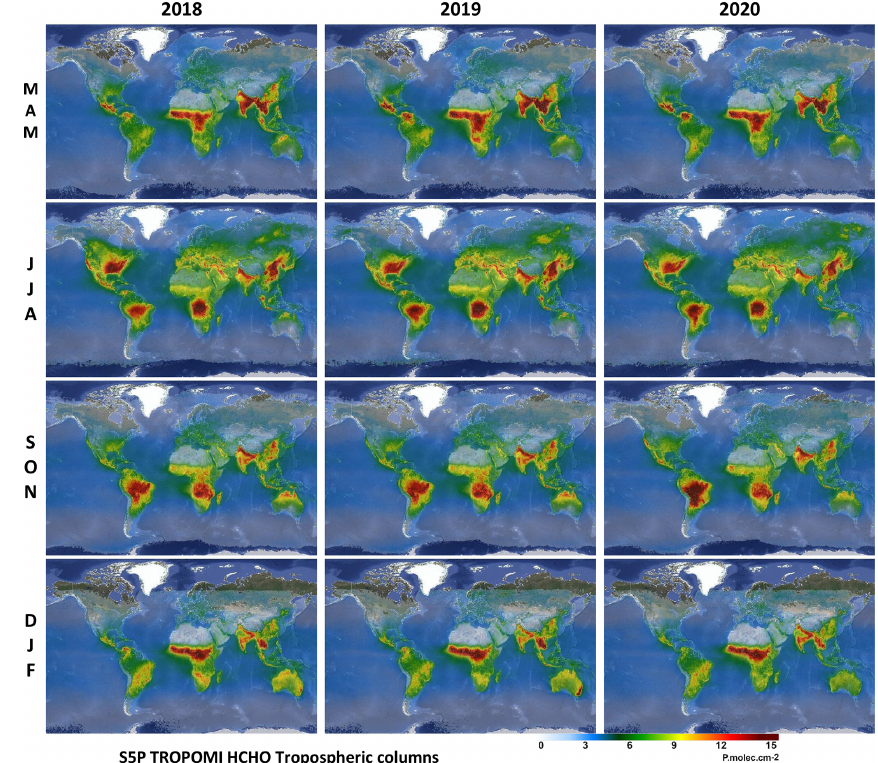
Figure 1. Seasonal maps of TROPOMI HCHO tropospheric columns during the first 3 years of measurements (March 2018–February 2021), on a spatial grid of 0.05 ◦ in latitude and longitude. Observations are filtered using the qa_values > 0.5 (max scale: 15 × 10 15 molec.cm − 2 ). Modified Copernicus Sentinel-5P satellite data, OFFL L2 HCHO product,